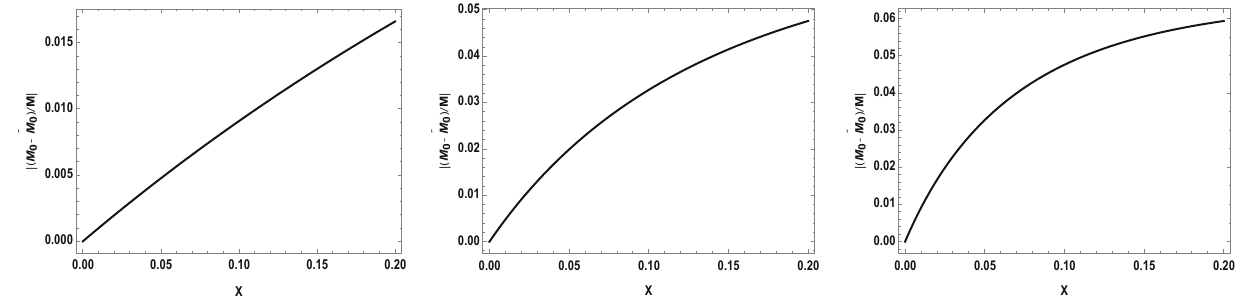
Fig. 3 Upper panels: ratios ˜ M 0 / M (dotted line) and M 0 / M (dashed line) as functions of X for q V = 0 . 1 (left panel), q V = 0 . 5 (center panel) and q V = 1 (right panel). Bottom panels: ratios ˜ M 0 / M (dotted